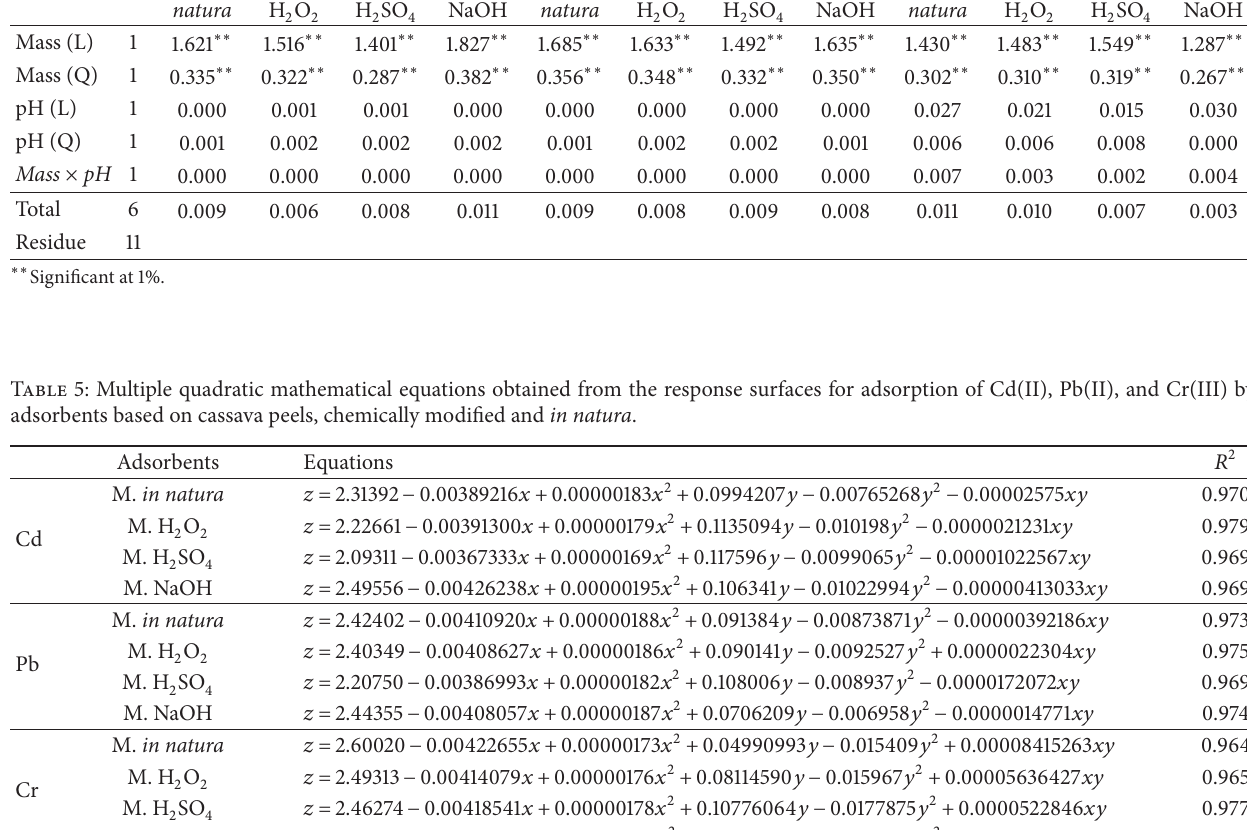
Table 4: Mean square and summary of analysis of variance (ANOVA) are displayed to forecast model for the influence of the masses of cassava and pH solution on the removal of Cd(II), Pb(II), and Cr(III) to the adsorbents in natura and modified. FV GL